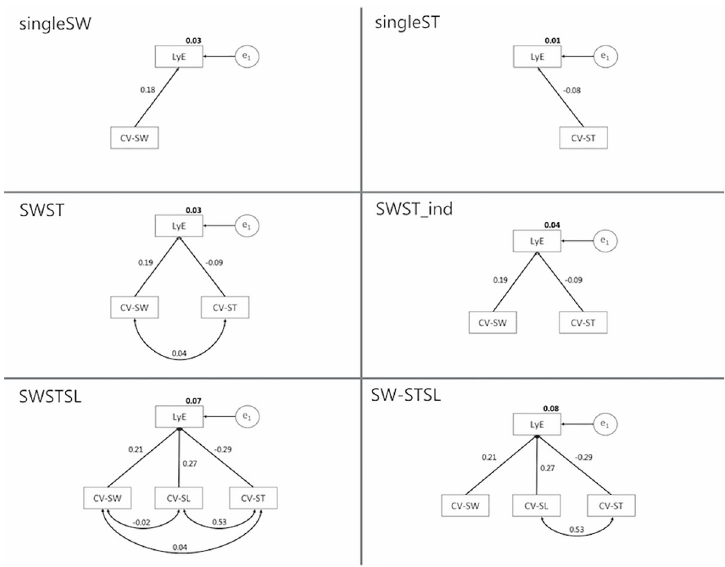
Fig 3. Overview of all SEM models with total variance explained (bold) and standardised correlation coefficients.